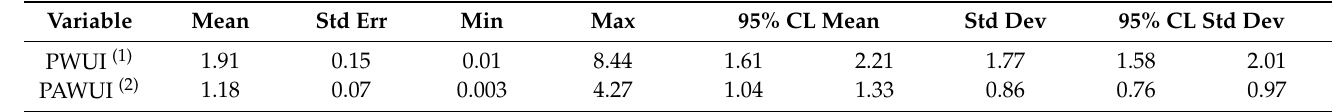
Table 9. Mean values and confidence intervals for water unit intensity (WUI) pre-audit and post-audit.